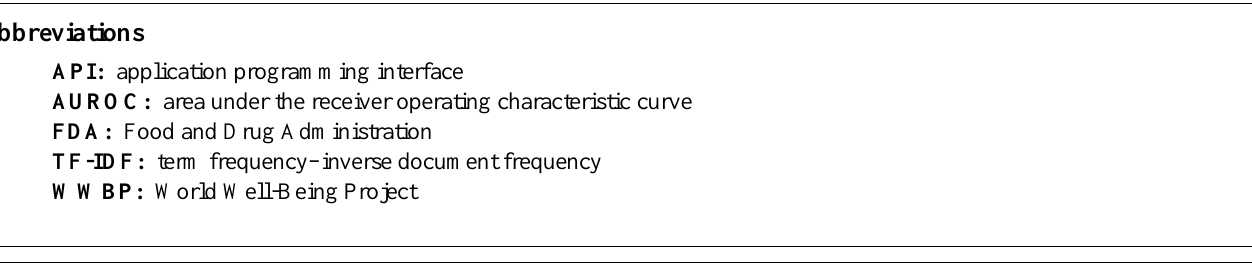
Reddit advertising policy: prohibited advertisements. Reddit. URL: https://advertising.reddithelp.com/en/categories/ reddit-advertising-policy/reddit-advertising-policy-prohibited-advertisements [accessed 2021-02-01]